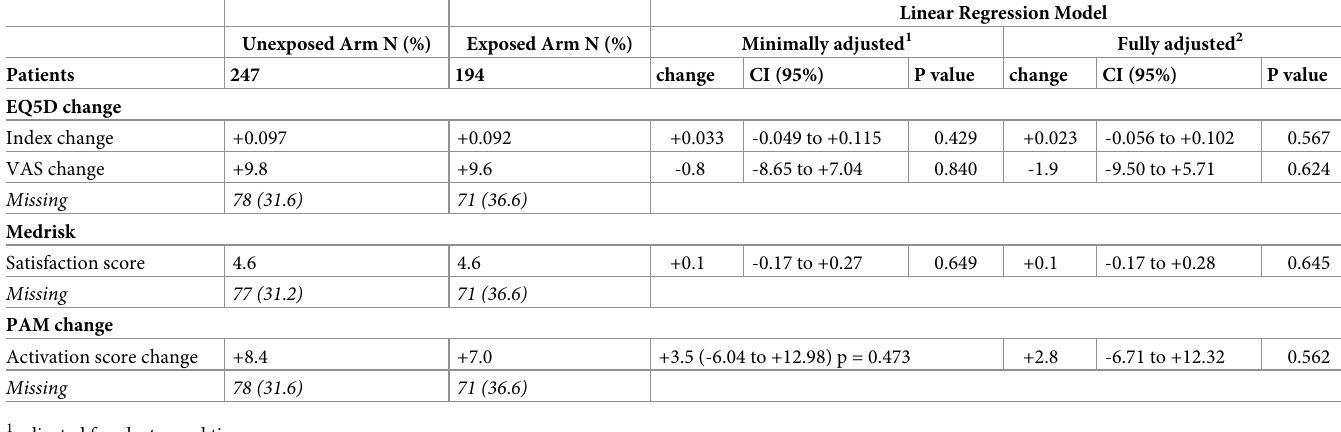
Table 5. Summary of secondary outcome measure by exposure to the intervention, with adjusted and unadjusted intervention